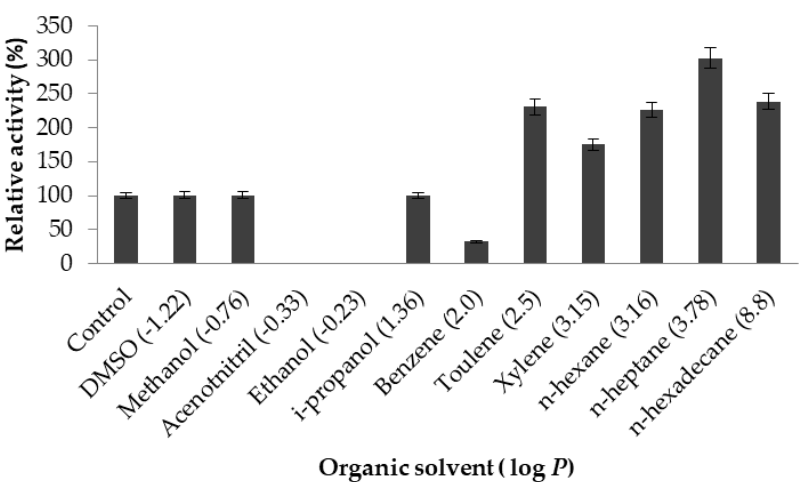
Figure 10. Effect of solvents on purified LSK25 lipase. The assay was carried out using olive oil as a substrate. Incubation time for the treated enzyme with organic solvent was 30 min, at 25 °C and assay at 30 °C. Remaining lipase activity was expressed relative to that of the control. Log P (water/octanol coefficient) value of each solvent are indicated in parentheses. Error bars represent standard deviations of means ( n = 3).